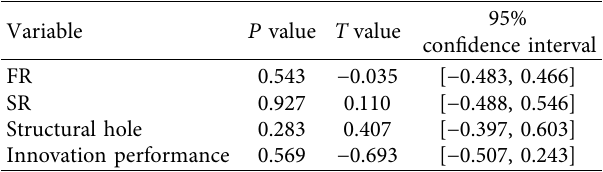
Table 4: Te result of the nonresponse bias test.